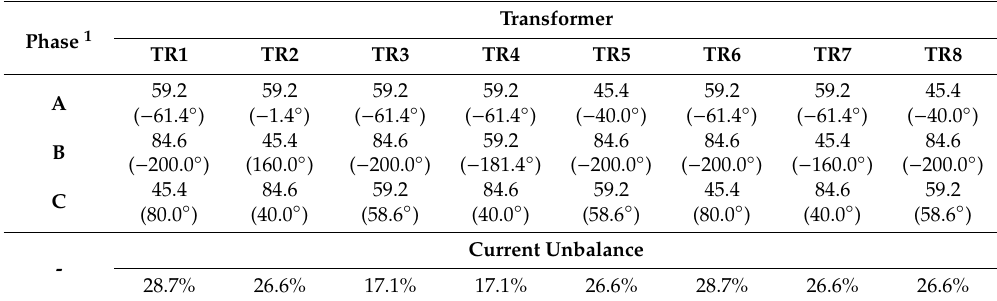
Table 3. The load connected to each transformer and its respective current unbalance.